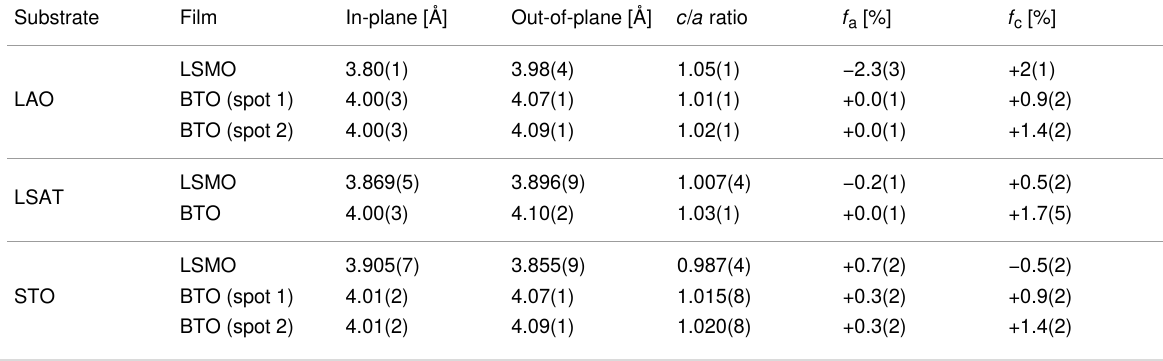
Table 1: In- and out-of-plane lattice parameters, c / a ratio, and lattice deformation for BTO and LSMO layers in the heterostructures (bulk values at room temperature are: a LSMO = c LSMO = 3.876 Å [36], a BTO = 3.999 Å, c BTO = 4.033 Å [37]).